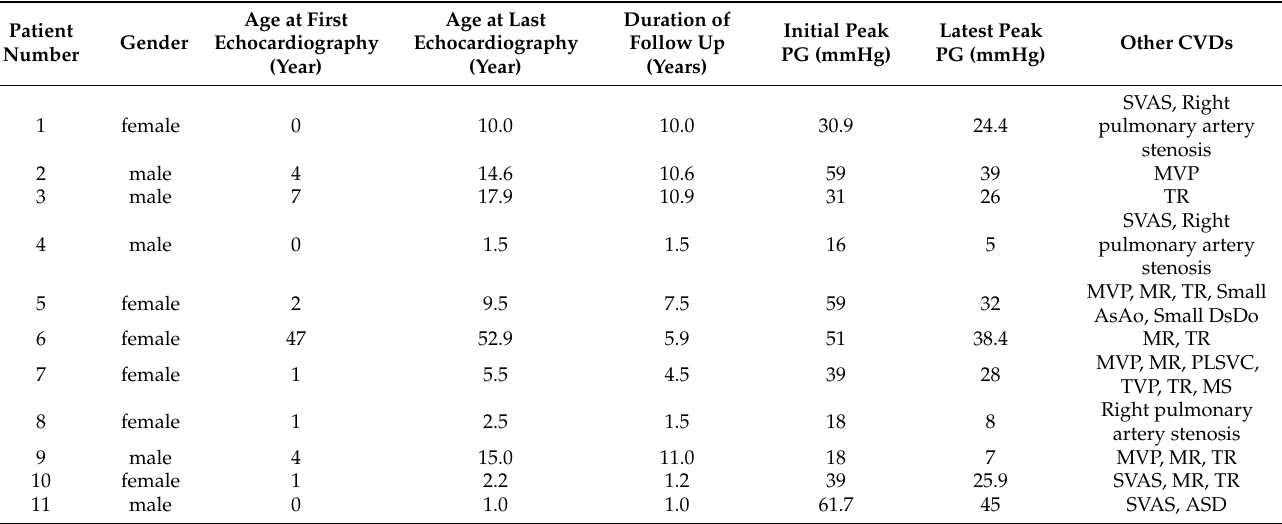
Table 4. The baseline characteristics and comorbidities in branch